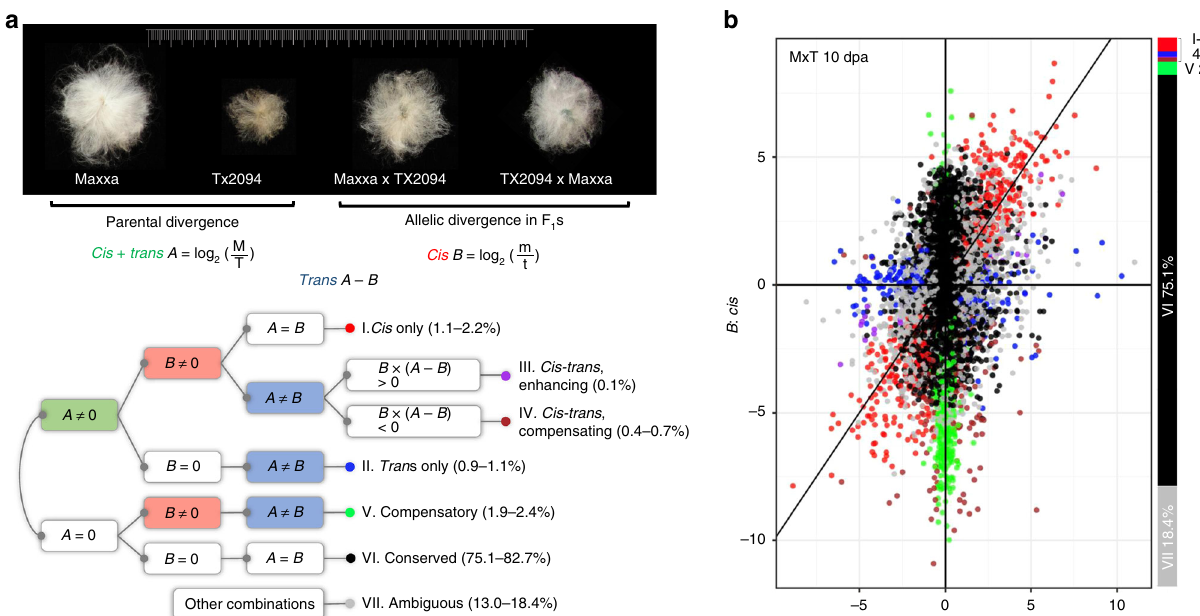
Fig. 1 Parental and F 1 hybrid expression data enable the ASE study of G. hirsutum domestication. a Using parental and F 1 allelic expression divergence between wild and domesticated cottons, genes were assigned into one of seven regulatory categories representing combinations of cis and trans regulatory effects. Brie fl y, differential expression of any given gene in the parents re fl ects both cis and trans divergence ( A ), whereas the expression of the same gene in the common trans environment of the F 1 hybrid re fl ects cis regulatory divergence ( B ) between parental alleles. While trans divergence cannot be directly measured, it can be inferred via the difference in A − B . See methods for additional description. Next to each category, the percentage range of genes was obtained from four sample conditions (M × T and T × M hybrids each at 10 and 20 dpa). b Taking the 10 dpa sample of the F 1 hybrid M × T as an example, the scatter plot of cis regulatory divergence ( y -axis) vs. parental expression divergence (x-axis) is shown for all seven categories of genes. Category I – IV together only account for 4.1% of 27,816 genes, with the majority of genes assigned to categories of conserved (VI – 75.1%), ambiguous (VII – 18.4%), or compensatory regulation (V – 2.4%). The source data underlying Fig. 1b are provided as a Source Data fi